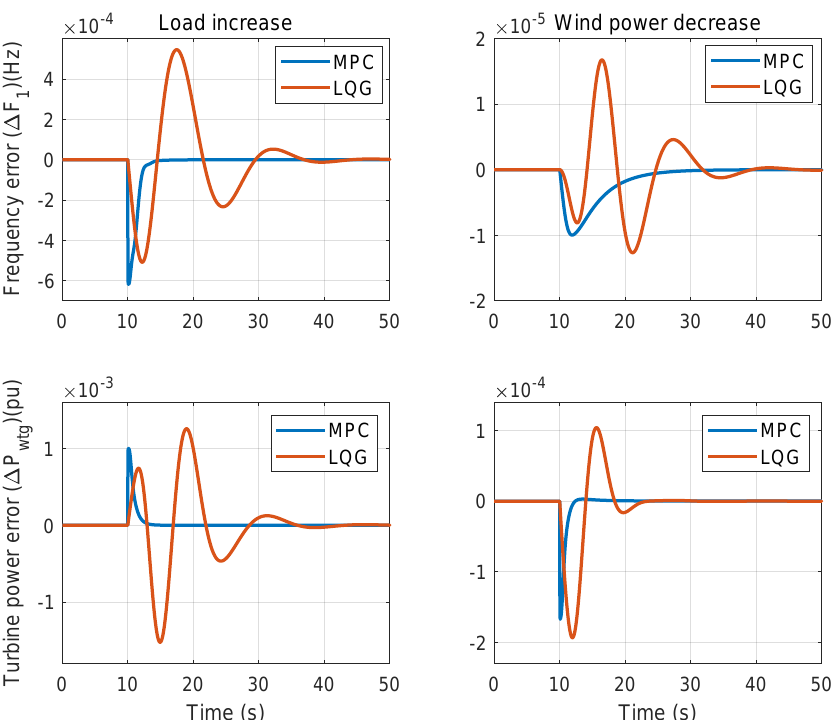
Figure 6. Robust performance of the proposed decentralized MPC and the benchmark decentralized LQG controllers against step disturbances in the load and wind powers applied at t = 10 (s) with the amplitude of 0.01 (pu).